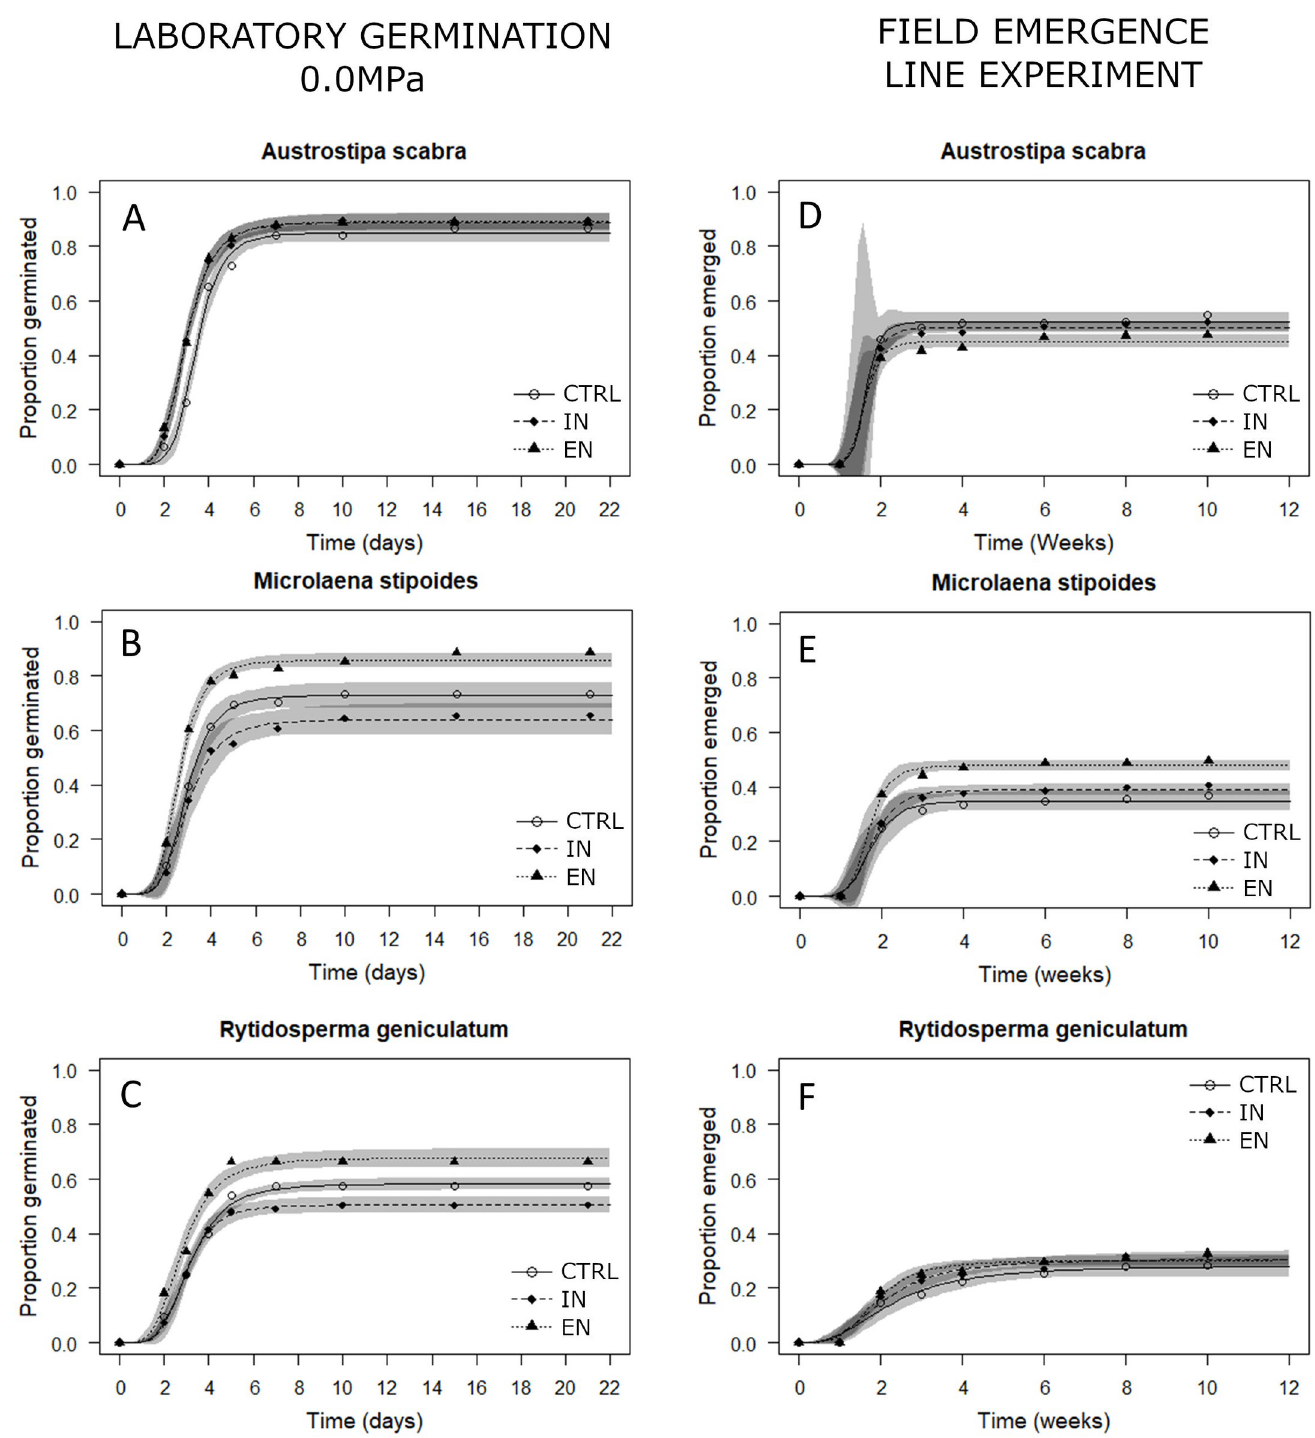
Fig 3. Seed treatment germination and emergence curves. Cumulative germination/emergence percentage curves for the three different seed treatments: Untreated (CTRL), encrusted (EN), and imbibed (IN) across the three species tested ( Austrostipa scabra , Microlaena stipoides , Rytidosperma geniculatum ). The lines represent cumulative germination over time. Data points are the germination recorded on a specific day/week and the shaded areas represent the 95% confidence intervals. A, B and C germination experiments were in controlled laboratory condition. D, E and F are seedling emergence in the field trials.